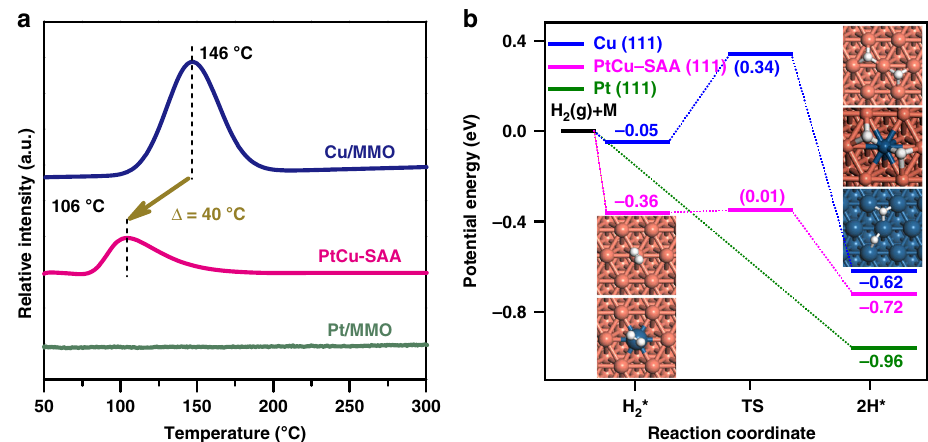
Fig. 6 Hydrogen dissociation and spillover capacity. a Surface H 2 – TPR spectra of various samples after N 2 O – oxidation pretreatment: Pt/MMO, PtCu – SAA, and Cu/MMO. b Potential energies pro fi les for H 2 dissociation pathways on the (111) facet of various samples: Pt/MMO (green line), PtCu – SAA (magenta line) and Cu/MMO (blue line), respectively. Numbers in the parentheses represent the reaction barriers of elementary step, and others stand for adsorption energies. H 2 (g) denotes gas phase of H 2 . Cu, orange, Pt, blue, H,